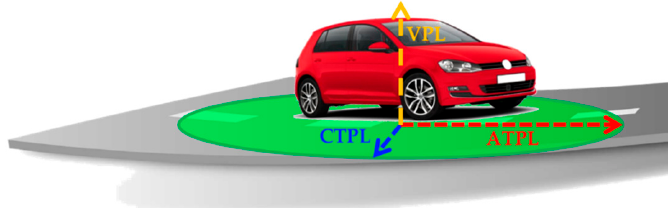
Figure 2. Concept of Along-Track, Cross-Track, and Vertical Protection Levels.